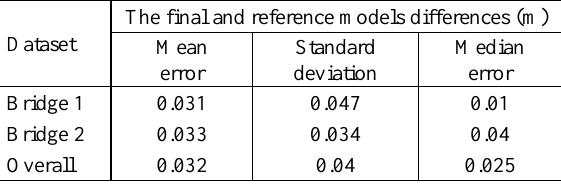
Table 4. The evaluation of final 3D